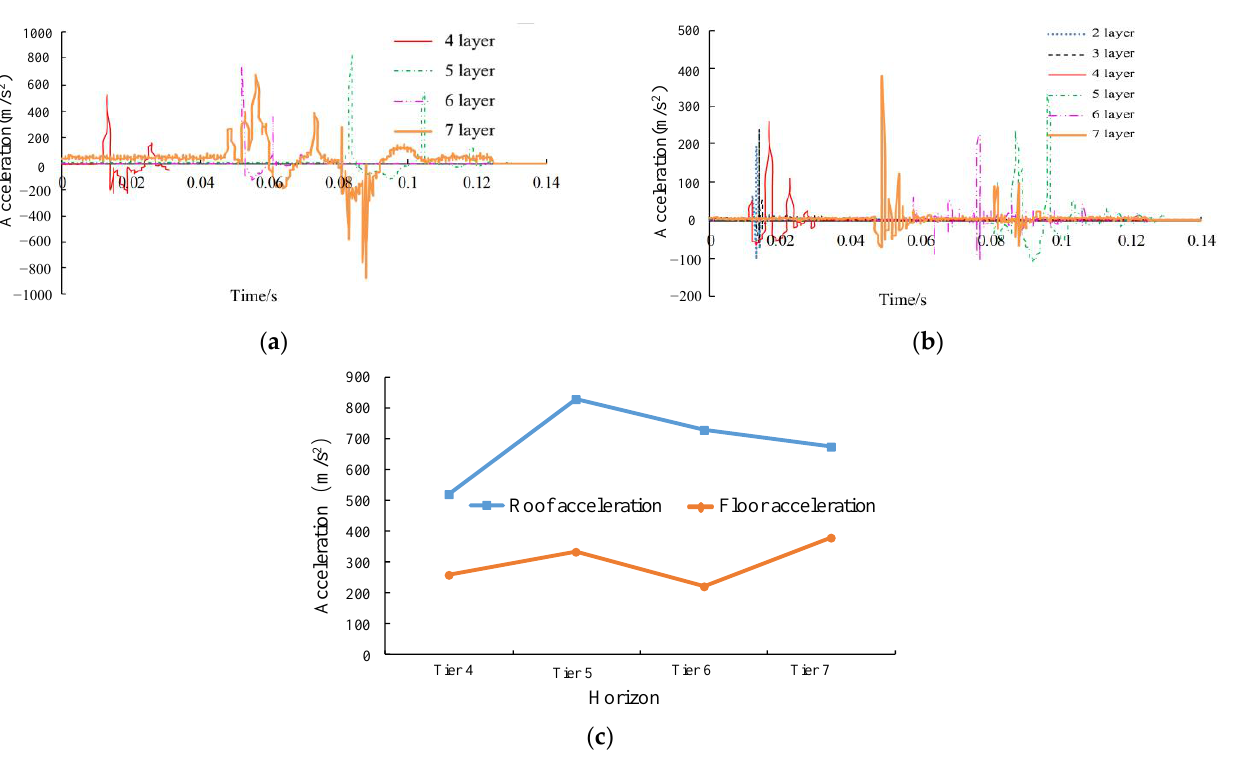
Figure 18. Acceleration response characteristics of each layer when the pendulum height is 0.4 m. ( a ) Acceleration at the roof of surrounding rock; ( b ) Acceleration at the floor of the roadway; ( c ) Peak acceleration at each level.